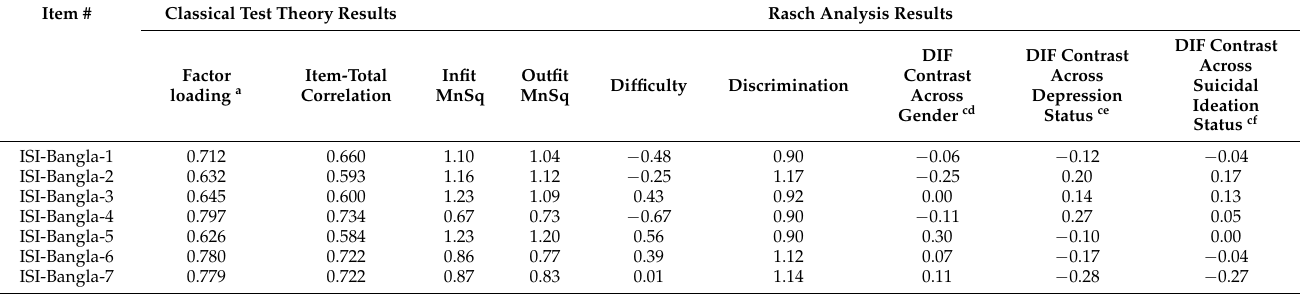
Table 4. Psychometric properties of the Insomnia Severity Index (ISI) in item level.